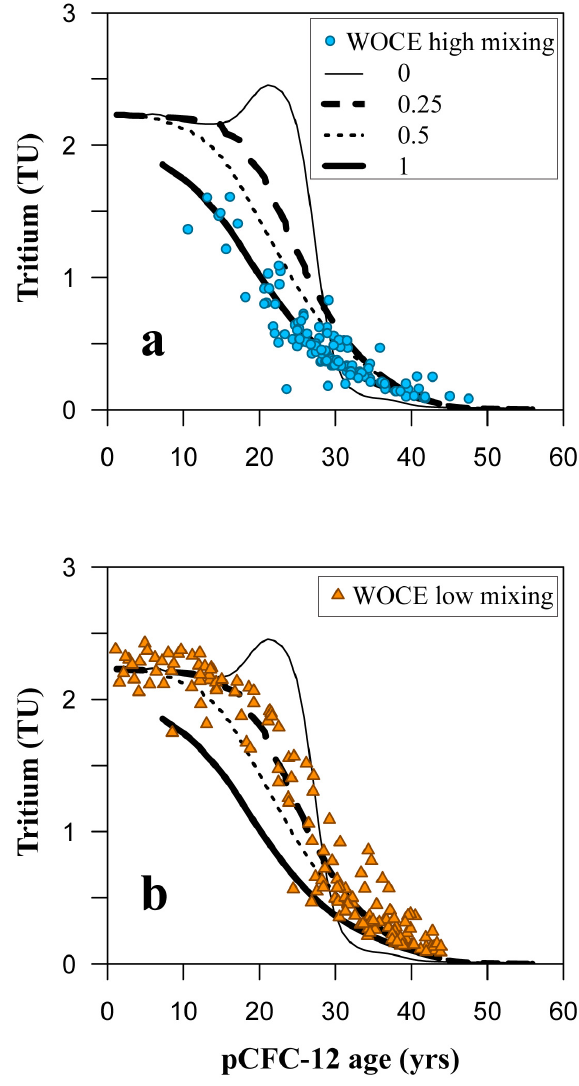
Fig. A1. The relationship between North Pacific pCFC-12 age and tritium concentrations normalised to year 1991 for observations and TTD-estimates based on Eqs. (A1) and (A2). Observations (blue circles and yellow triangles) are from WOCE cruises PO4E (1989), P16C (1991), P17C (1991), P17N (1993), and P19C (1993). Obser- vations are classified as “high mixing” (surface nitrate concentra- tions > 1µM) and “low mixing” samples (surface nitrate concentra- tions < 1µM) (see text for discussion on selection criteria). Samples with tracer concentrations below detection limits (i.e., CFC-12 con- centrations < 0.01pM; 3 H < 0.08TU) have been excluded. Black lines indicate the TTD-estimated pCFC-12 age and tritium values assuming a 0 / 1 ratio of 0, 0.25, 0.5, and 1 (thin solid, dashed, dotted and thick solid lines, respectively). “High mixing” samples fit the ratio 1 line very well ( R 2 = 0 . 95, total sum of square error technique) and “low mixing” samples fit the 0.25 ratio line well ( R 2 = 0 . 85).